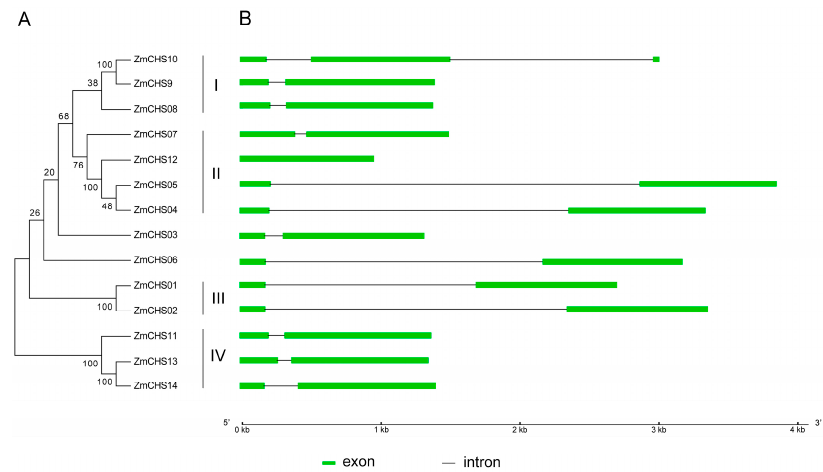
Figure 1. Phylogenetic tree and gene structure of the 14 predicted maize chalcone synthases (CHS s ) . ( A ) The unrooted neighbor-joining tree was constructed using the MEGA4.0 program. The bootstrap values, which were produced using 1000 replicates with the pairwise deletion option, are noted at each node; ( B ) Exon-intron structure was generated using Gene Structure Display Server (GSDS). The exons and introns are indicated by green boxes and gray lines, respectively. The scale at the bottom is in